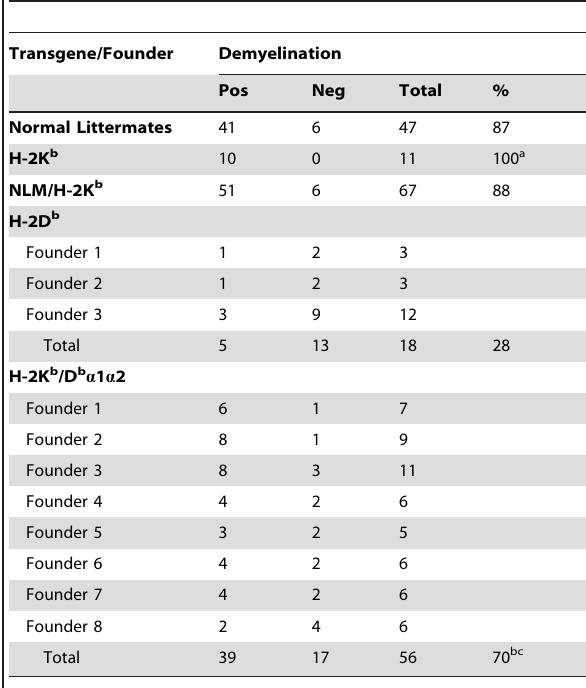
Table 1. Spinal cord